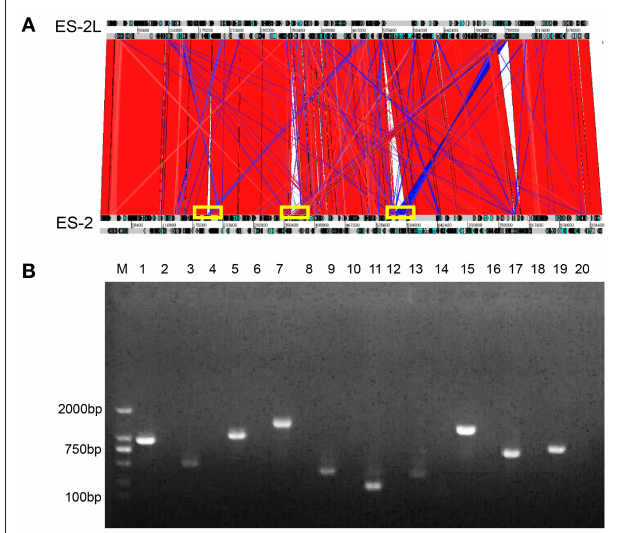
FIGURE 3 | (A) Collinearity analysis results of strains ES-2L and ES-2; strain ES-2L showed three large fragment deletion regions indicated by the yellow box, compared with ES-2. (B) Confirmation of the deleted genes by PCR. M, DNA marker 2,000; lanes 1, 3, 5, 7, 9, 11, 13, 15, 17, and 19 correspond to genes E5E95_00935, E5E95_00940, E5E95_01845, E5E95_01850, E5E95_01855, E5E95_01860, E5E95_01905, E5E95_03755, E5E95_00670, and E5E95_00665 with strain ES-2 genome as a template, respectively. Lanes 2, 4, 6, 8, 10, 12, 14, 16, 18, and 20 indicate that these genes were amplified with strain ES-2L genome as template.